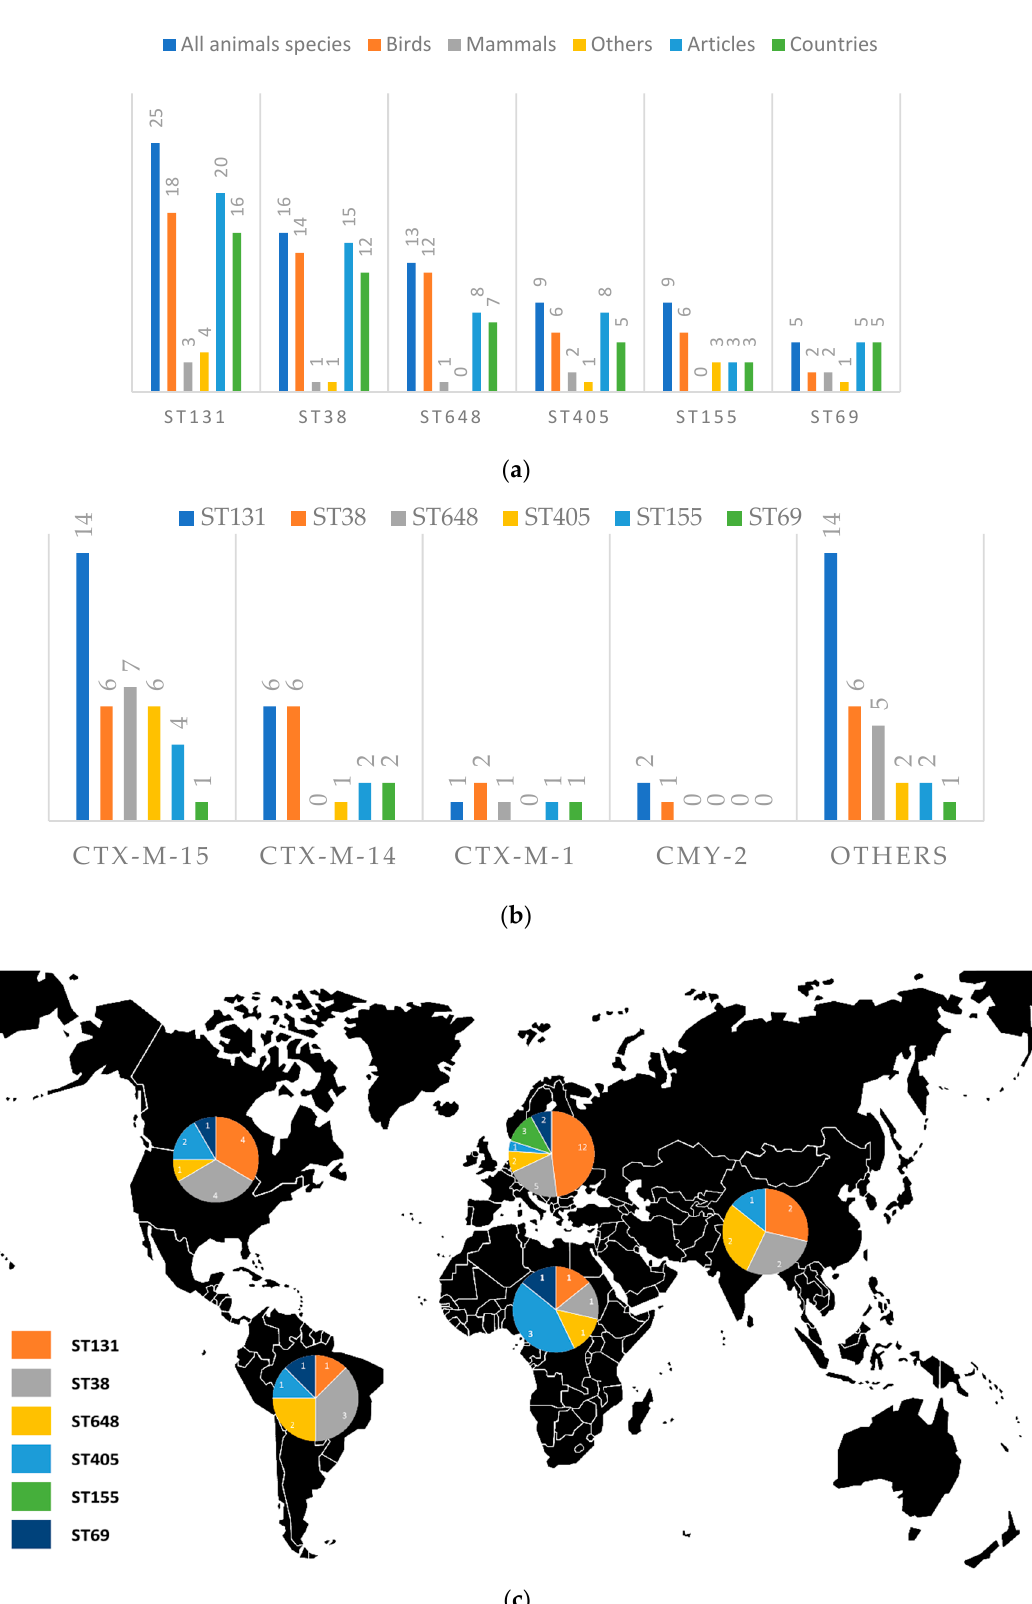
Figure 8. Details of high-risk clones of E. coli associated with cephalosporinases in wild animals, including (a) animals species and taxa, publications and country numbers, (b) their co-occurrence with the top 4 reported cephalosporinases and (c) distribution per continent.